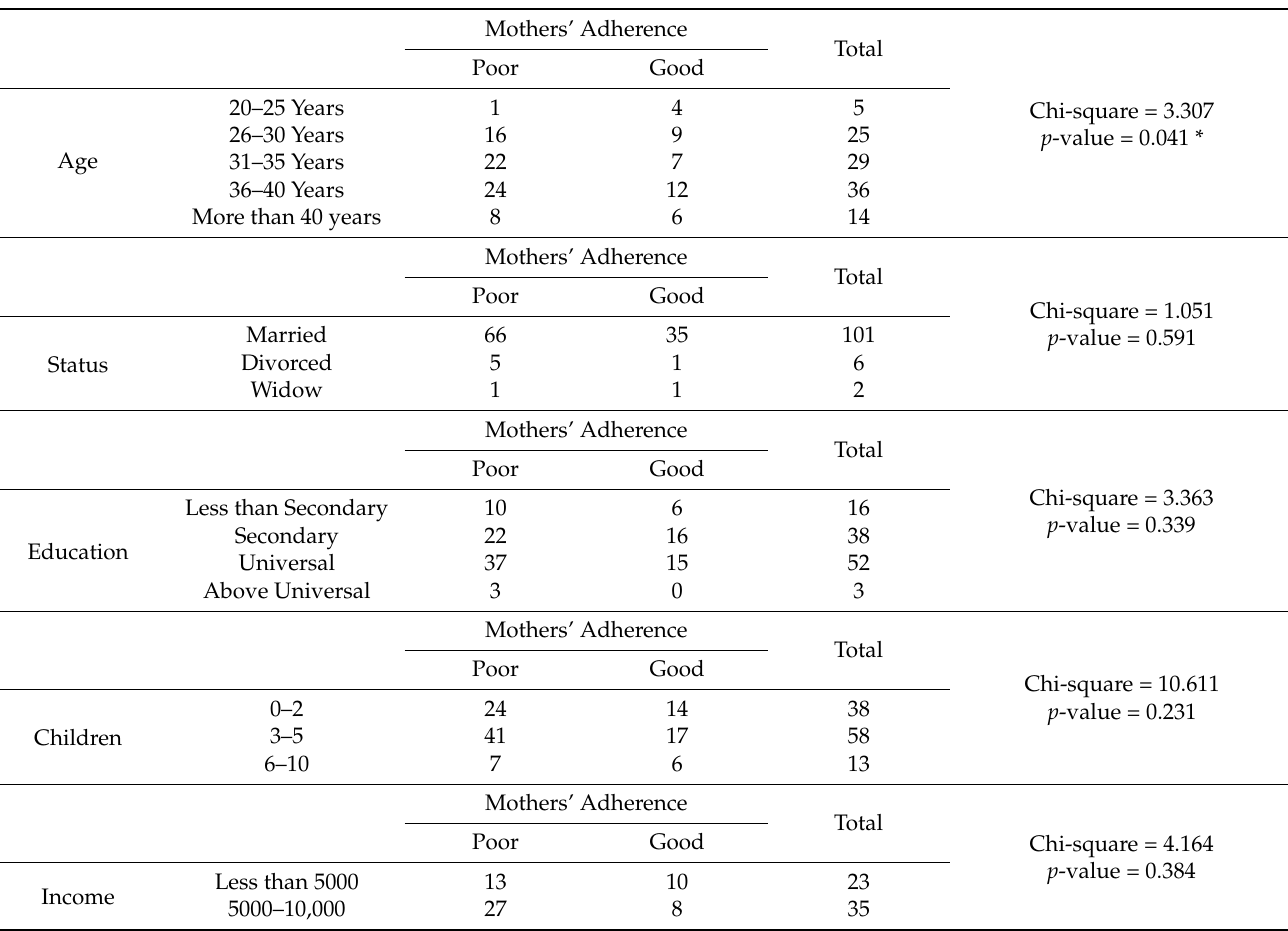
Table 3. Chi-square test results for analyzing association between mothers’ demographics and their adherence to HEP. Mothers’ Adherence